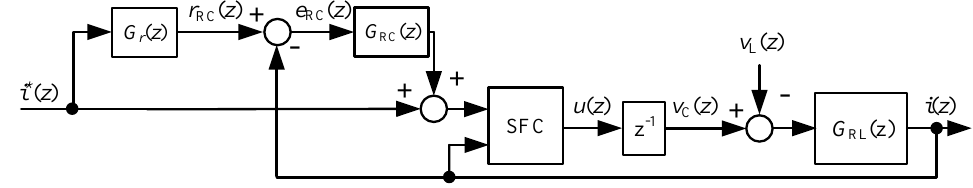
Figure 7. Scheme of the repetitive control insensitive to reference signal changes.